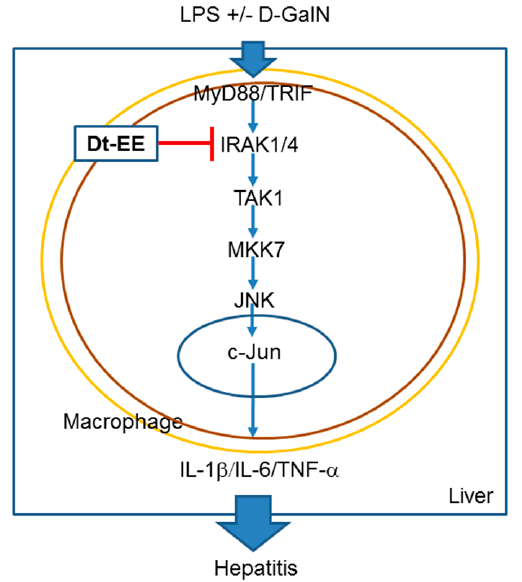
Figure 5. Scheme for Dt-EE-mediated anti-inflammatory activity along the AP-1 signaling path- way.